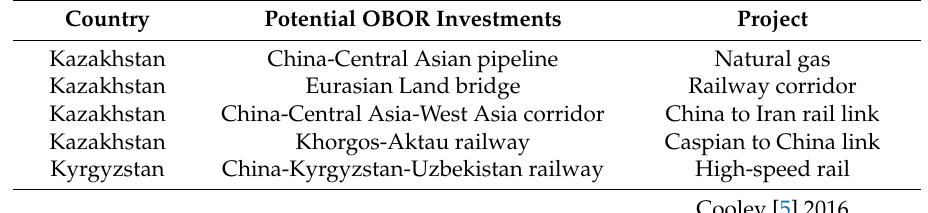
Table 5. Proposed One Belt, One Road (OBOR)